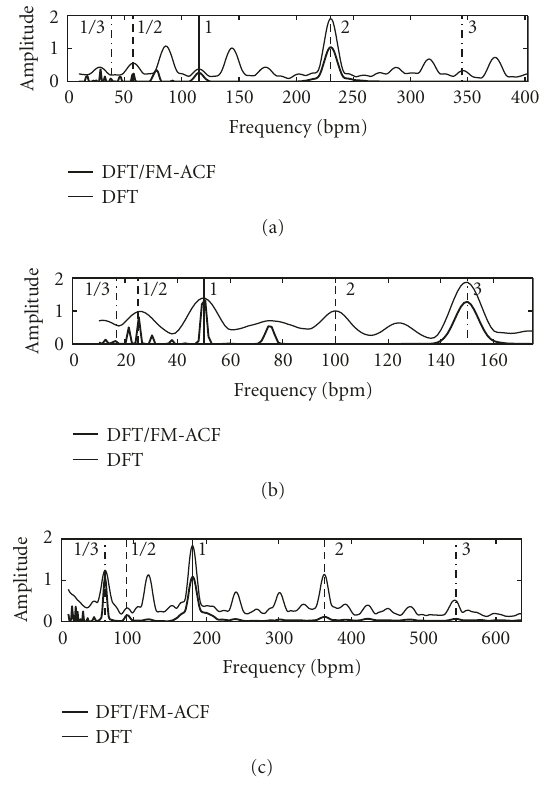
Figure 7: Comparison between the DFT (thin line) and the combined DFT/FM-ACF (thick line) measured on real signals: (a) quadruple/simple meter, (b) duple/compound meter, (c) triple/simple meter. Superimposed: ground-truth tempo (1), 1/2 and 2 time the tempo, 1/3 and 3 time the